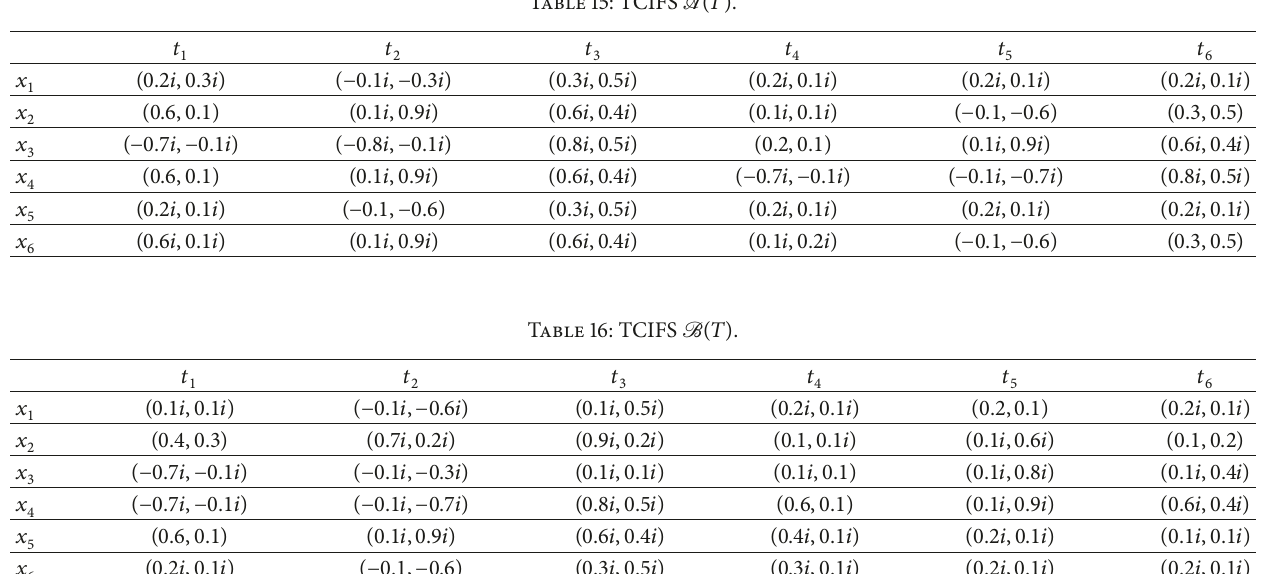
Table 15: TCIFS A (𝑇) .